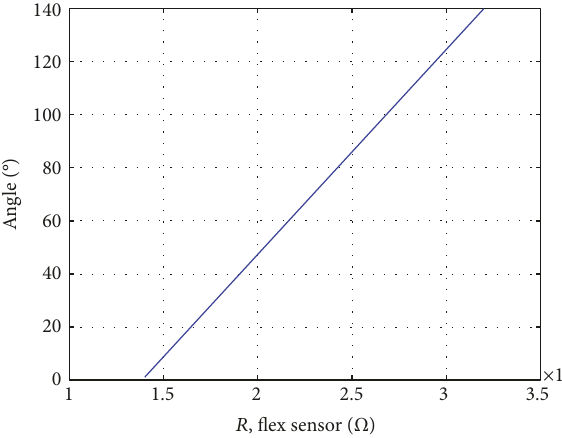
Figure 10: Flex sensor resistance depending on elbow